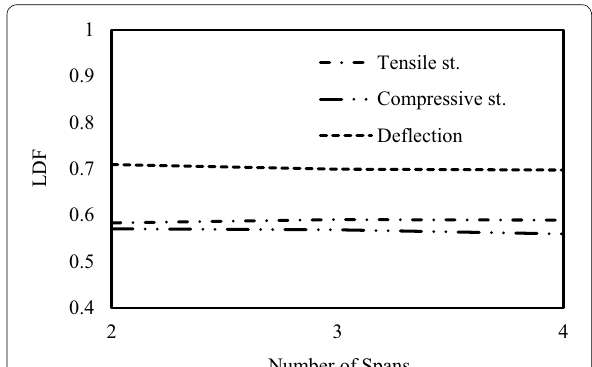
Fig. 16 Effect of the number of spans on DF for a three box girder bridge with a total span length of 45